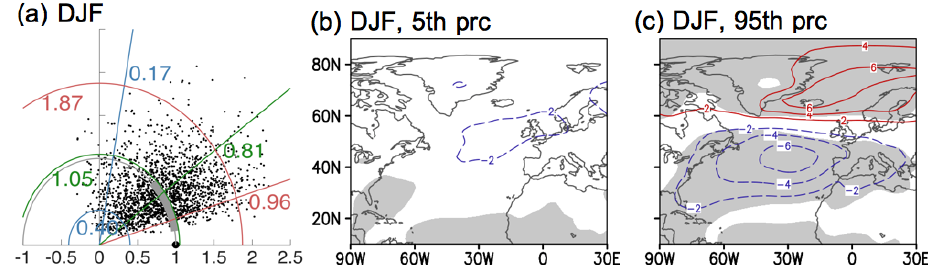
Figure 3. Taylor diagram for polar (poleward of 60 ◦ N) North Atlantic in DJF with 2000 bootstrap SLP composites, and the 5th and 95th percentile maps. These panels correspond to the first column in Fig. 2. Features in the Taylor diagram are as described in Fig. 2. See Sect. 3.1 for more